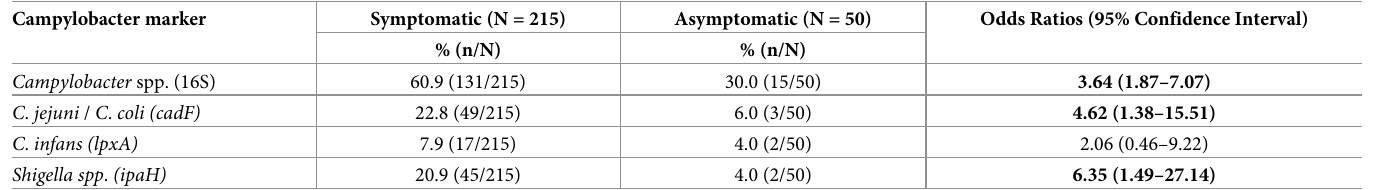
Table 2. Detection of Campylobacter spp., C . jejuni , C . coli , Candidatus Campylobacter infans and Shigella spp. in symptomatic and asymptomatic fecal samples from children in the Peruvian Amazon using a multiplex qPCR. Campylobacter